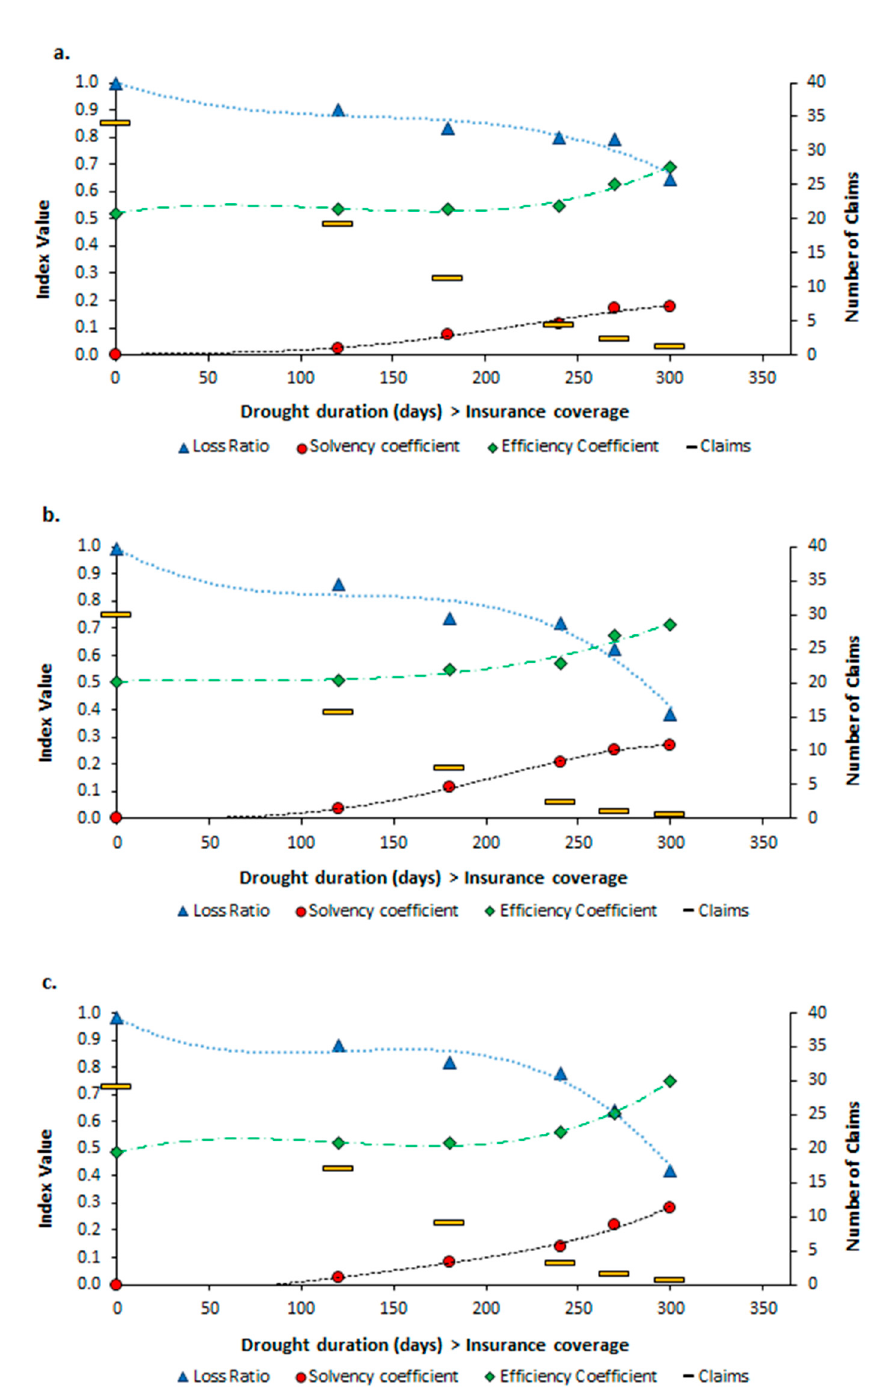
Figure 8. Performance indices of insurance scheme against hydrological drought (loss ratio, solvency coefficient, efficiency coefficient, and number of claims): ( a ) 2007–2040, ( b ) 2041–2070, and ( c ) 2071– 2099.